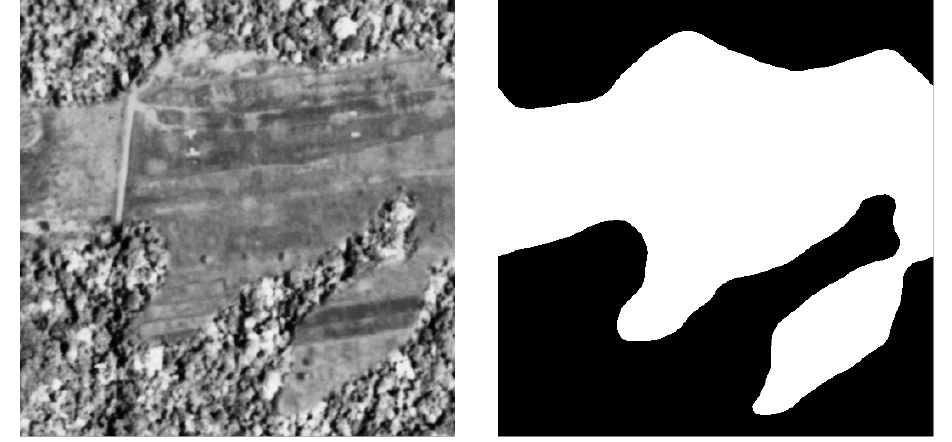
Figure 4. An example synthetic landscape, combining homogeneous forest and non-forest images into a patchy landscape using random Gaussian field-based masks: The left panel shows a combined synthetic landscape, while the right panel shows the corresponding forest (black) and non-forest (white) labels.